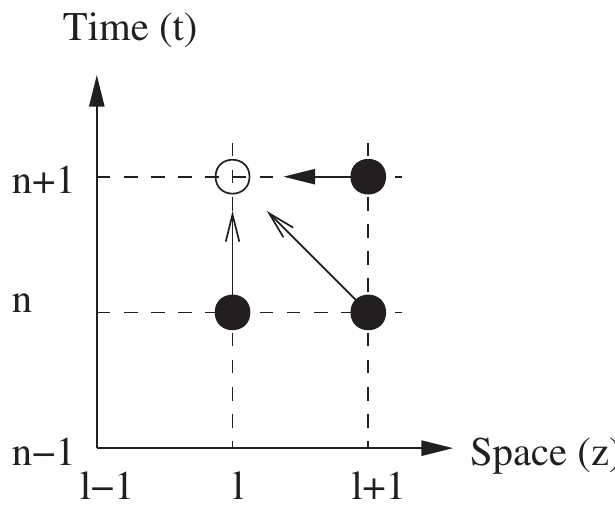
FIG. 2. Implicit integration scheme showing which points in space and time are used to solve for the point to be updated. Here the iteration runs from forward to back and requires initializing the furthest upstream point in order to solve for all others (set to zero if sufficiently